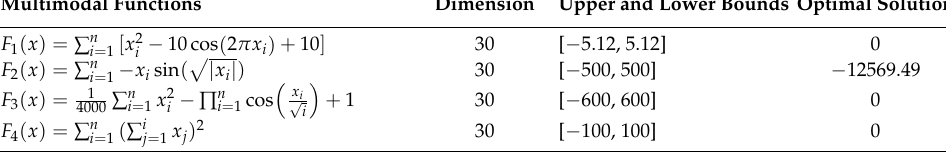
Table 6. Test function.